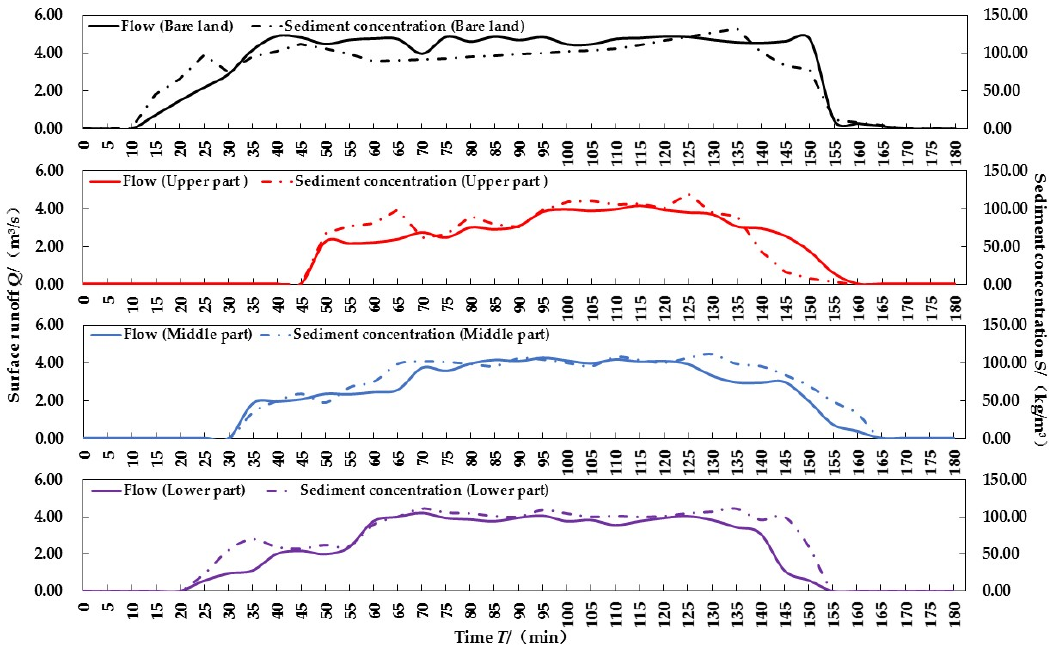
Figure 4. Comparison of water and sediment changes in different spatial positions ( y -axis) of terraced fields in high-management watershed.